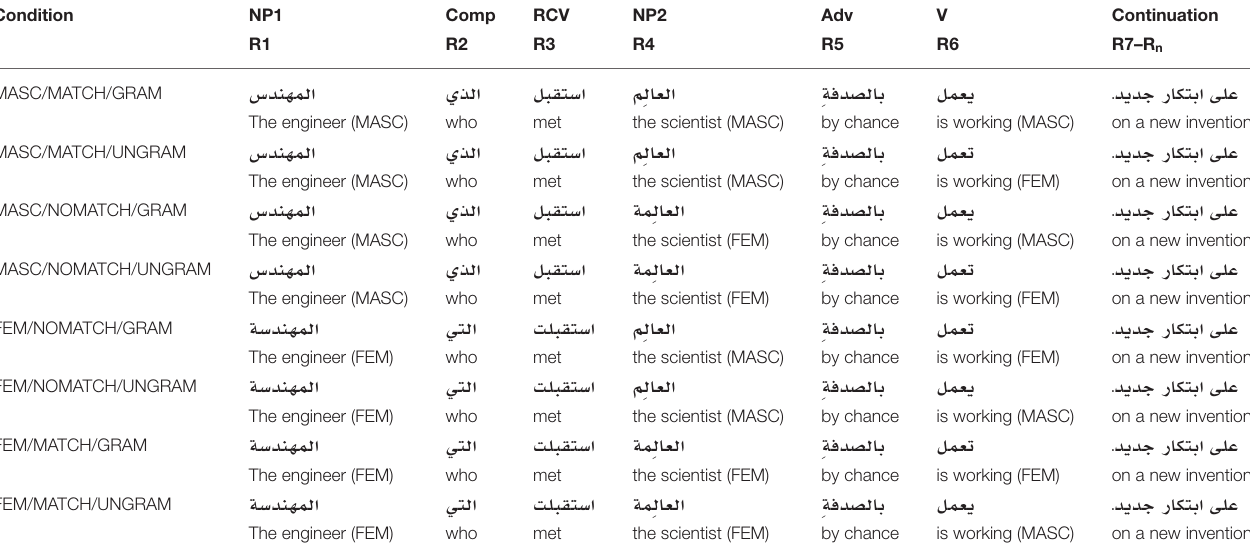
Table 3 | A complete item set for one stimulus in Experiment 2.